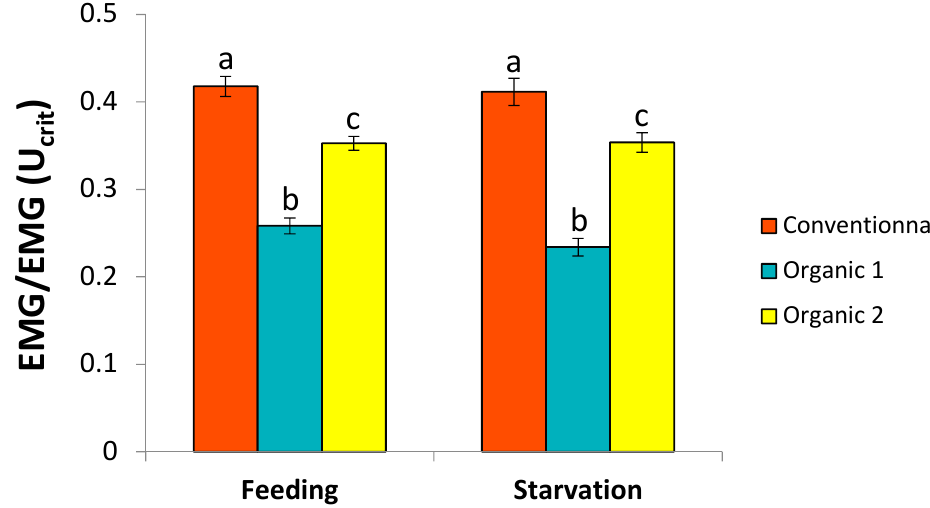
Figure 2. Mean ± SEM of the red muscle activity recorded (EMG)/red muscle activity at the U crit (EMG U crit ) during the feeding starvation periods for the three diets. Different letters indicate significant difference between diets (Tukey, p < 0.05).